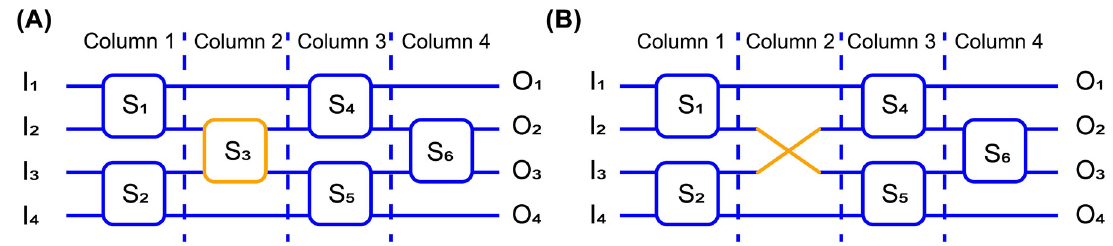
Figure 1: 4 × 4 Spanke–Beneš optical switch. (A) Conventional architecture. (B) Improved architecture.